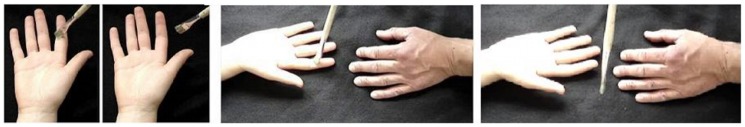
Conditions and types of stimuli used in the first experiment.The two pictures on the left depict the conditions touch hand and movements in peripersonal space, respectively, in 1PP. The two pictures on the right show touch hand and movements in peripersonal space, respectively, in 3PP.